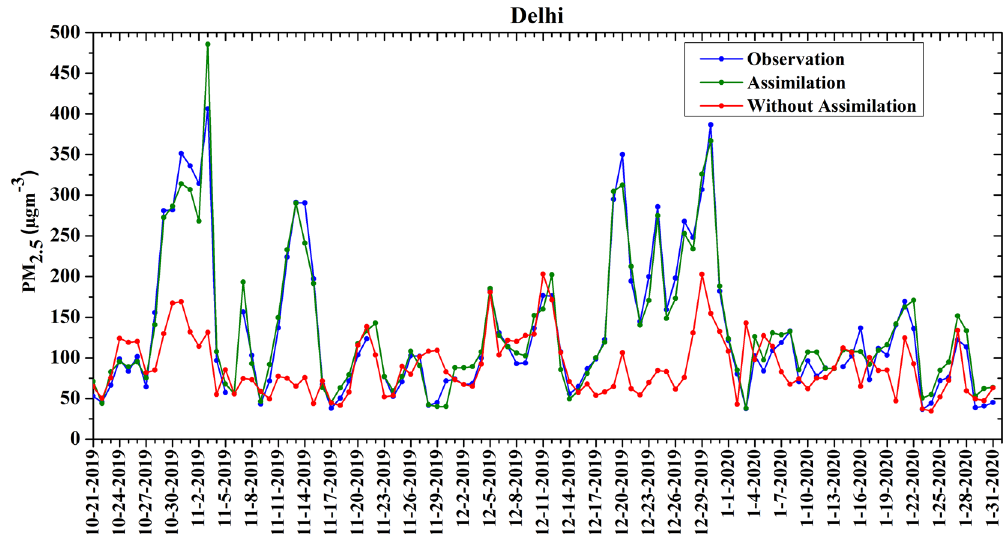
Figure 1. Averaged surface PM 2.5 simulated by the model before (red) and after (green) assimilation at 0900 UTC assimilation cycle and its comparison with observed mean PM 2.5 over Delhi during 21 October 2019 to 01 February 2020. The model output is averaged over the observational locations across